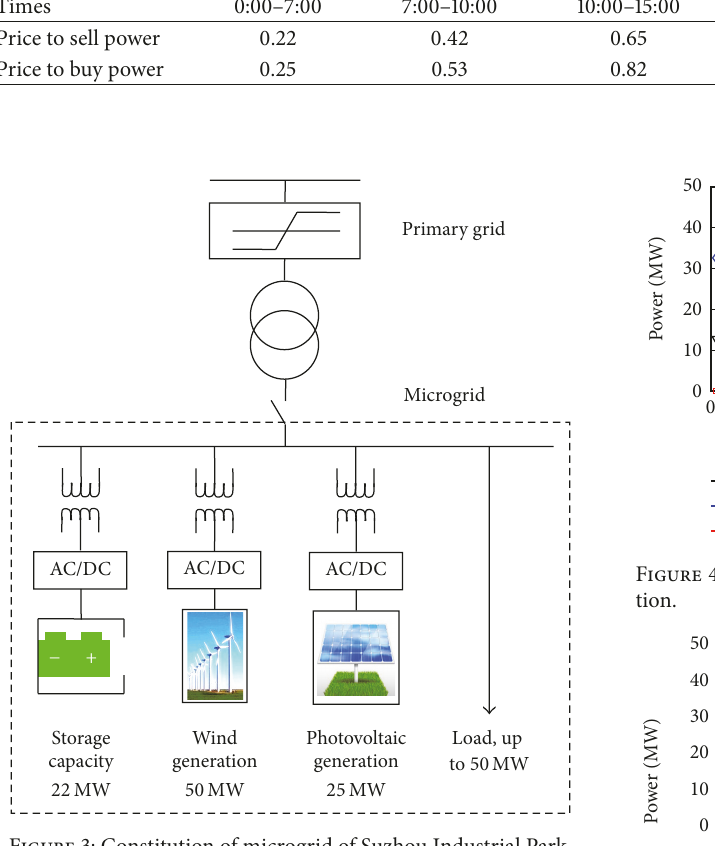
grid. And the wind generation power, the photovoltaic gener- ation power, and the exchanged power from the primary grid are indicated in Figure 5.